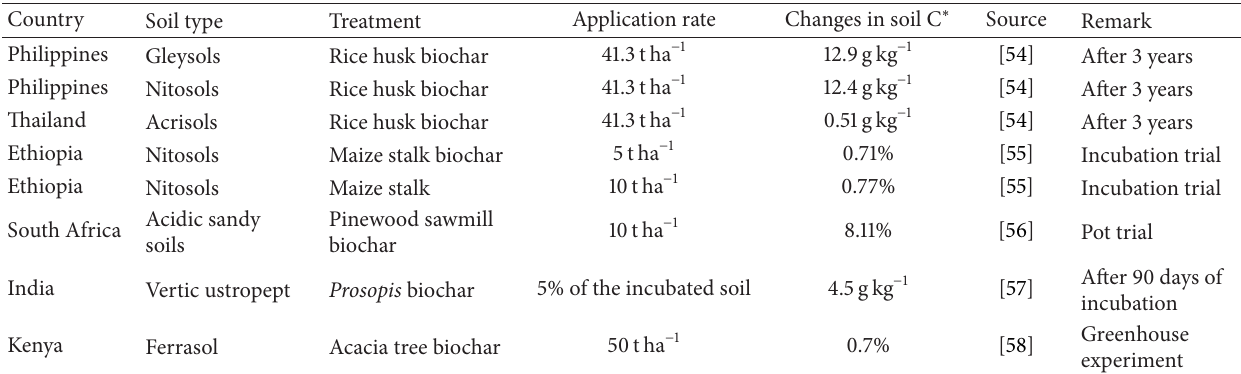
Table 1: Effects of biochar sourced from different biomass on soil C.